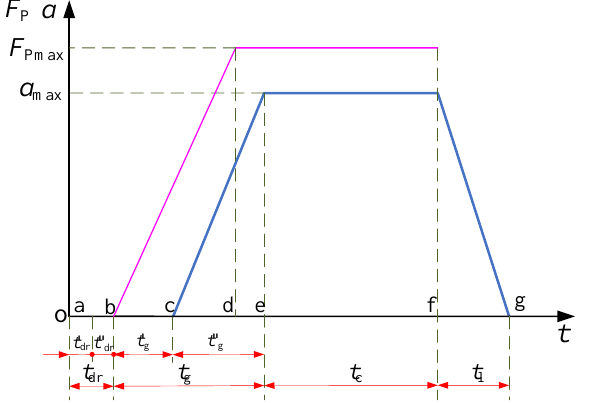
F , braking deceleration a , and braking time t. Figure 2. The curve of brake pedal force F P , braking deceleration a , and braking time t